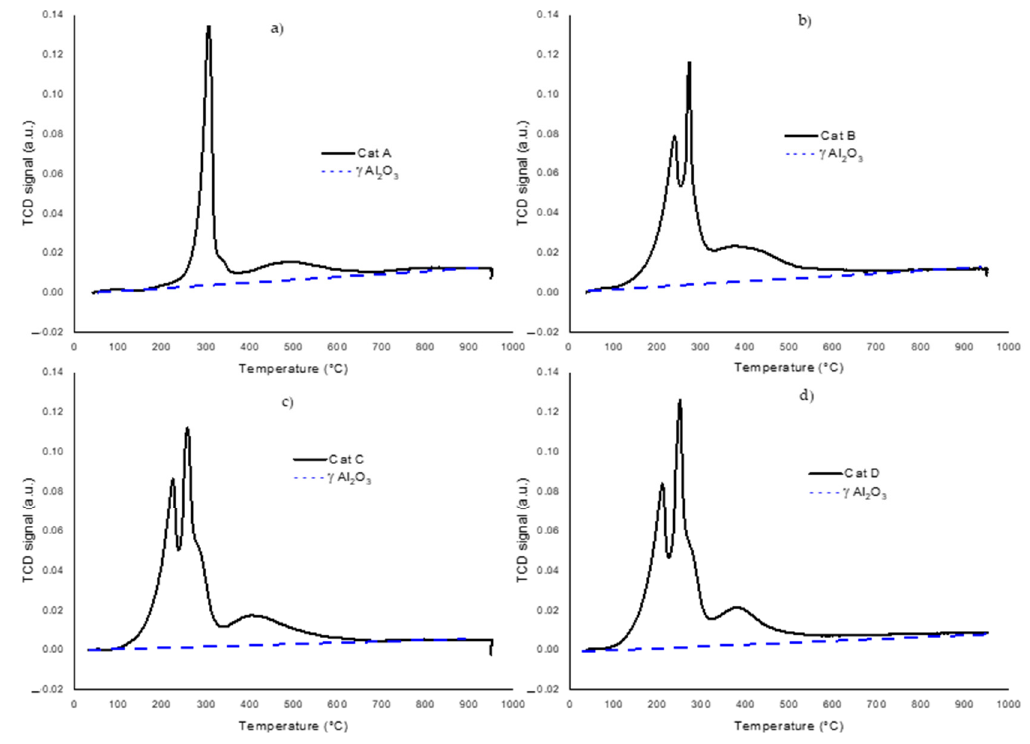
Figure 2. TPRs for fresh catalysts: ( a ) Cat A: 5% Ni/ γ Al 2 O 3 , ( b ) Cat B: 5% Ni–0.25% Ru/ γ Al 2 O 3 , ( c ) Cat C: 5% Ni–0.5% Ru/ γ Al 2 O 3 , ( d ) Cat D: 5% Ni–1.0% Ru/ γ Al 2 O 3 (heating ramp of 50 °C/min using 10% H 2 /90% He). Note: broken lines represent γ Al 2 O 3 .